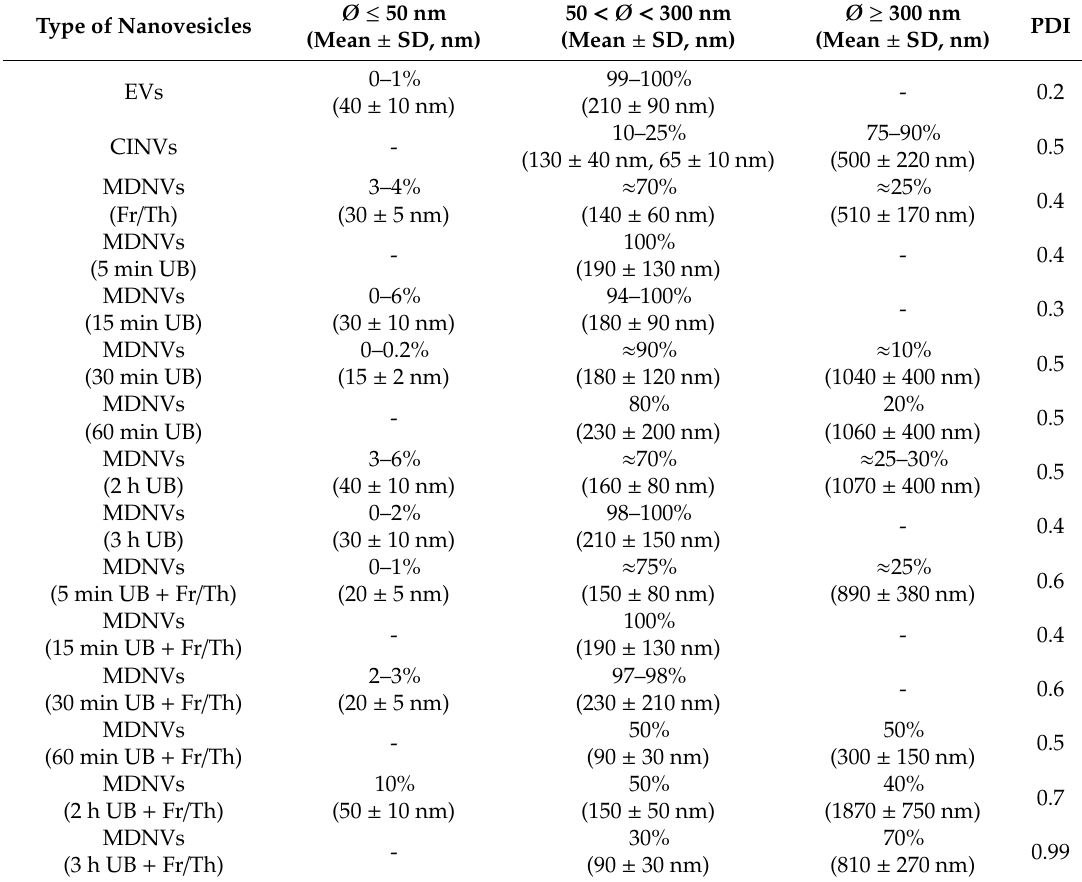
Table 1. Size distribution of MSC-derived EVs, CINVs, and MDNVs, as evaluated by DLS. Type of